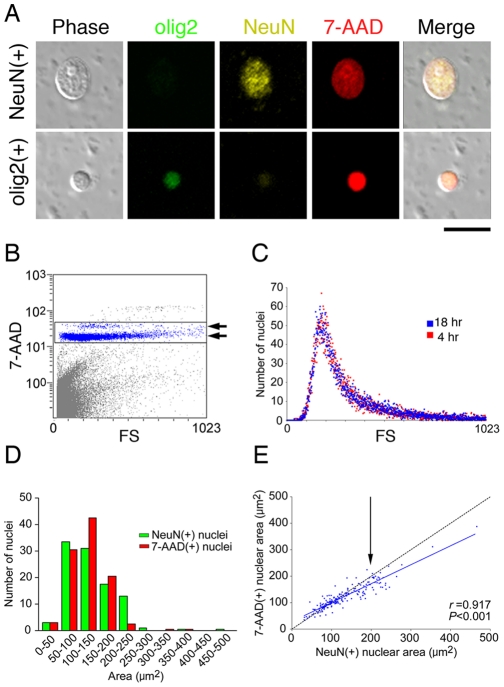
Validation of forward scatter (FS) values of nuclei isolated from frozen unfixed human postmortem brains.(A) Appearance of a human NeuN(+) (upper) or olig2(+) nucleus (lower) in PBS (280 mOsm). Scale bar, 20 µm. (B) FCM measurement of 7-AAD(+) nuclei. Arrows indicate two major populations of 7-AAD(+) nuclei. (C) Stability of isolated NeuN(+) nuclei in PBS. No difference was found in the FS distributions of NeuN(+) nuclei analyzed at 4 h and 18 h after homogenization, suggesting that the size of NeuN(+) nuclei remained quite stable in PBS. (D) Distribution of 7-AAD(+) (red) and NeuN(+) (green) nuclei areas (µ m2) as determined by microscopic measurements. The nuclei populations were delineated every 50 µm2. (E) Correlation between the areas of 7-AAD(+) and NeuN(+) nuclei (µ m2) as measured microscopically. The arrow (200 µm2 of NeuN(+) area) indicates a point that corresponds approximately to FS 400. Beginning with this point, the area of the NeuN(+) nuclei became gradually larger than that of the 7-AAD(+) nuclei, although the areas of the 7-AAD(+) and NeuN(+) nuclei correlated to a significant degree (r = 0.917, P<0.001).